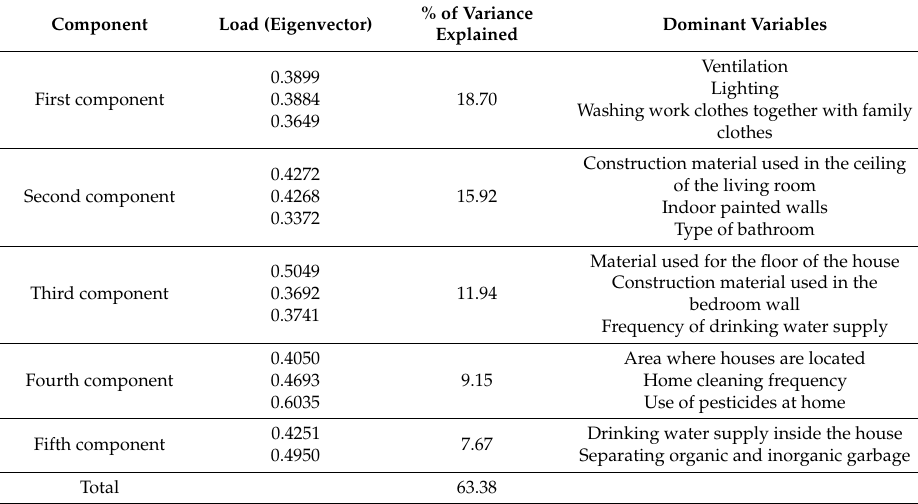
Selection of dominant variables in each component for the construction of the healthy-sustainable housing index